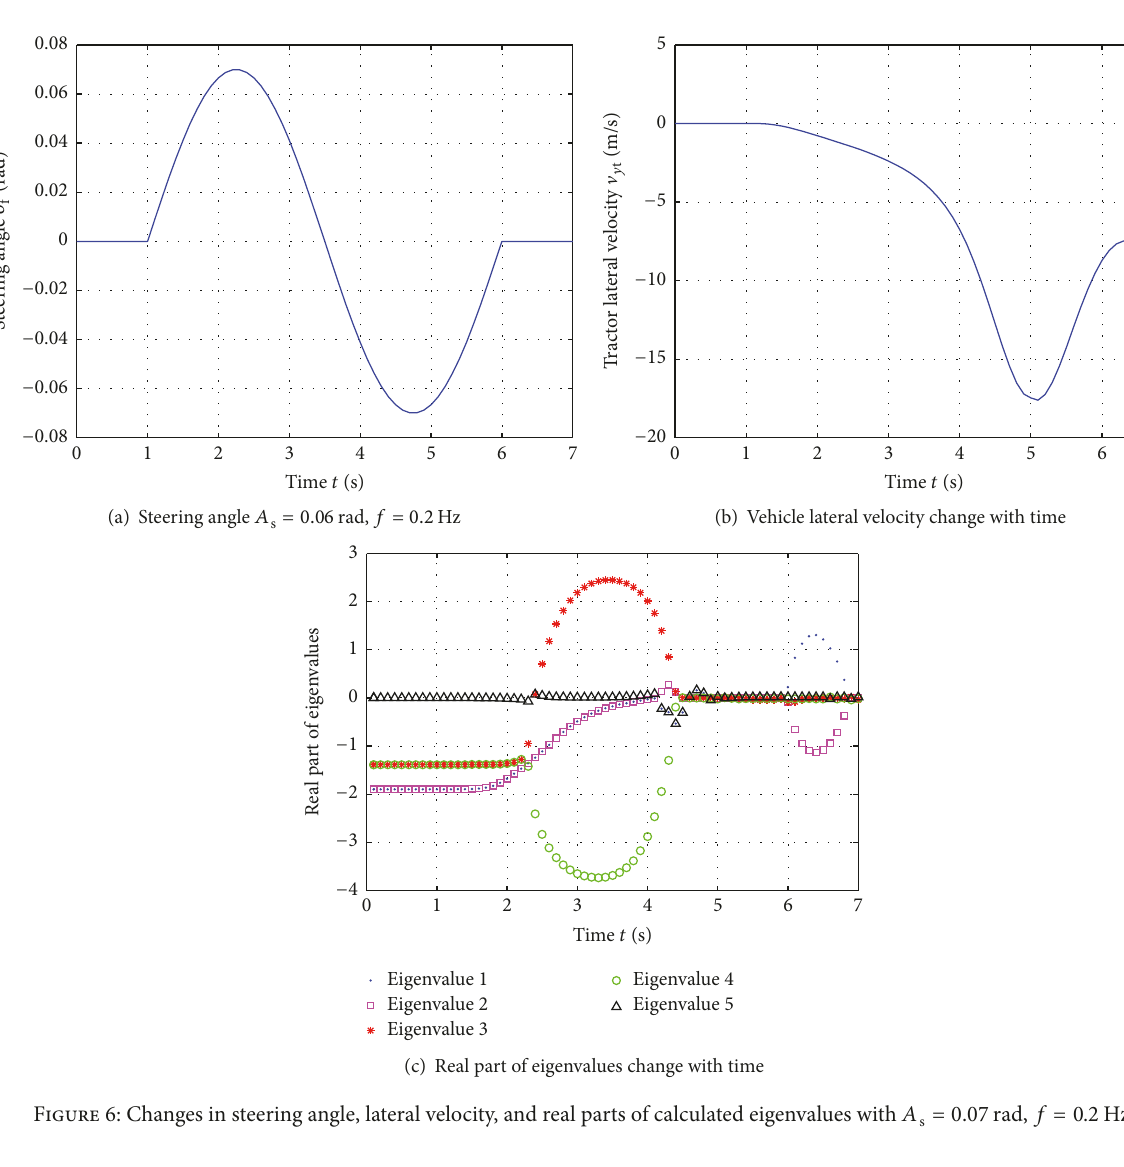
Figure 7: Limit circle of vehicle’s velocity with 𝐴